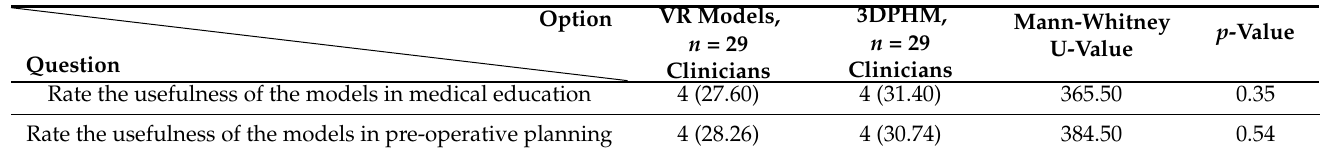
Table 5. Participants’ responses on the ratings for VR and 3DPHM a .